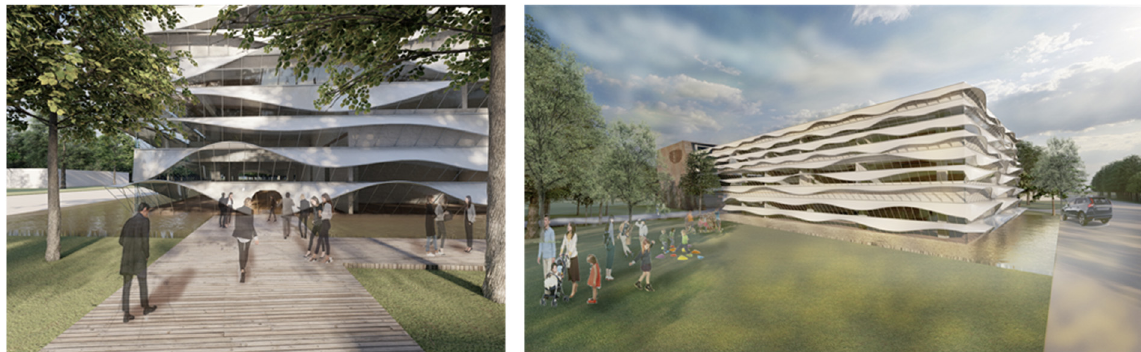
Figure 8. The comparison of different optimal solutions (Participant C).